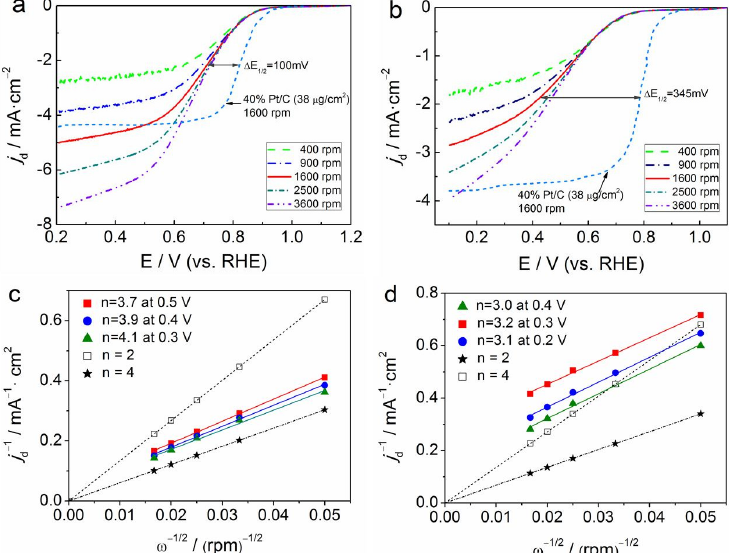
Figure 4. ( a ) The ORR polarization curves of N ‐ BC@CNP ‐ 900 in O 2 ‐ saturated 0.1 mol ∙ L − 1 KOH solution at different rotation rates (400–3600 rpm) and JM Pt/C catalyst in O 2 ‐ saturated 0.1 mol ∙ L − 1 KOH at 1600 rpm; ( b ) The ORR polarization curves of N ‐ BC@CNP ‐ 900 in O 2 ‐ saturated 0.5 mol ∙ L − 1 H 2 SO 4 solution at different rotation rates (400 − 3600 rpm) and JM Pt/C catalyst in O 2 ‐ saturated 0.5 mol ∙ L − 1 H 2 SO 4 solution at 1600 rpm; ( c ) Koutecky ‐ Levich plots of j d − 1 vs. ω − 1/2 obtained from Figure 4a; ( d ) Koutecky ‐ Levich plots of j d − 1 vs. ω − 1/2 obtained from Figure 4b.